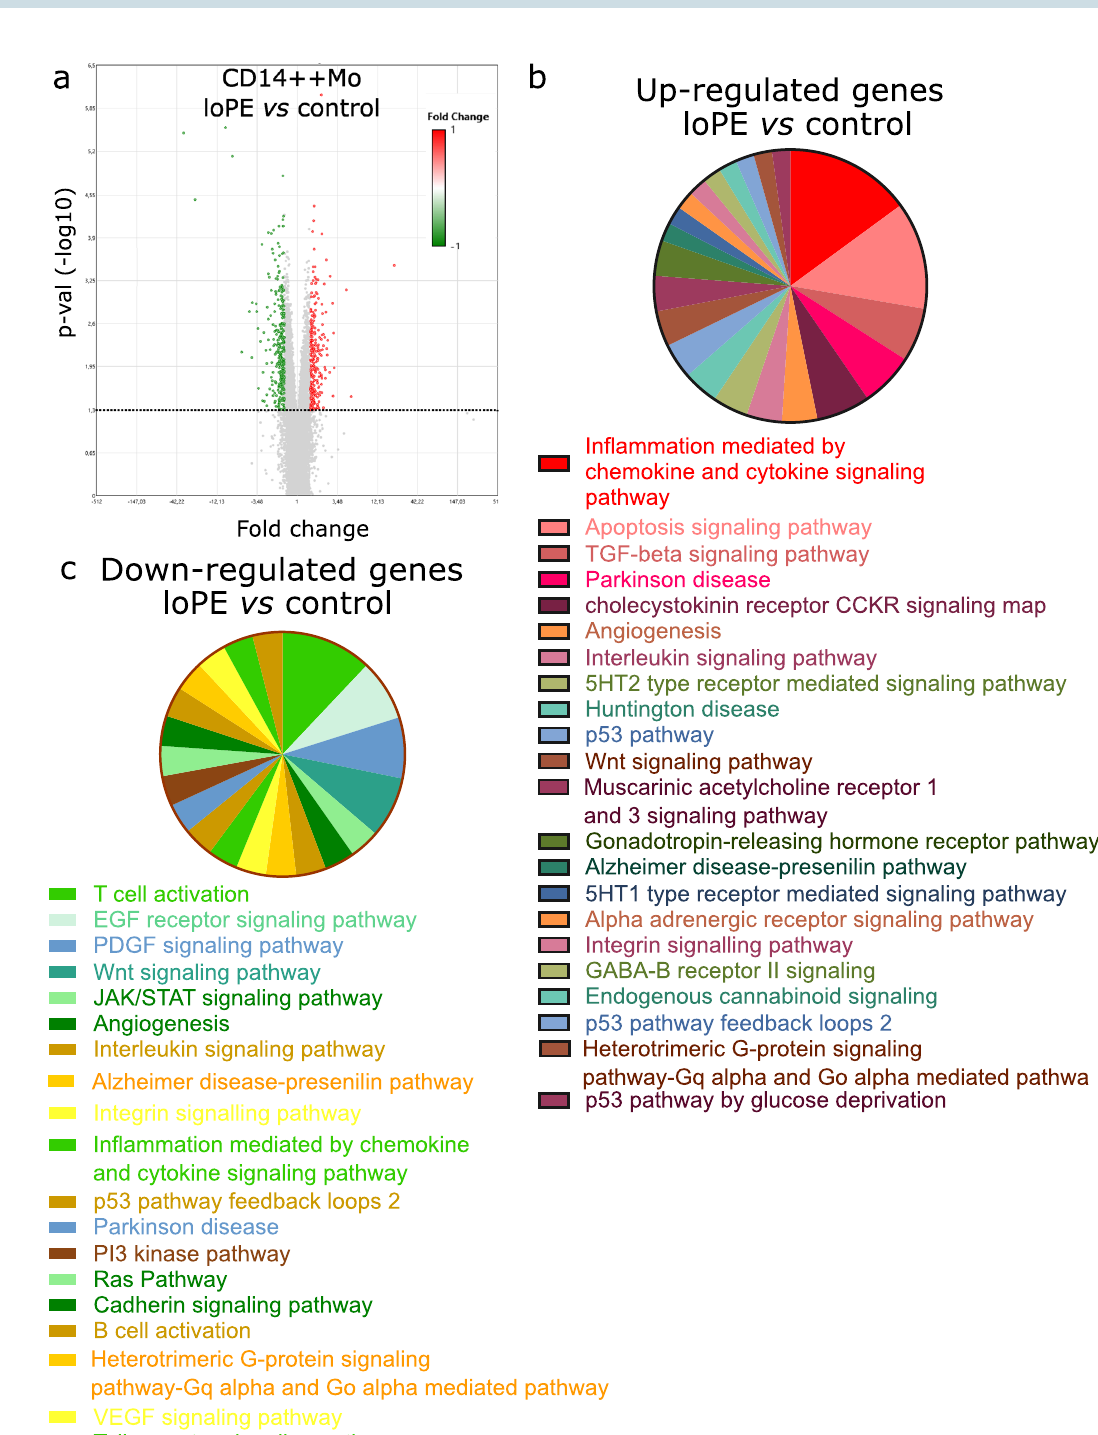
Figure 3. Transcriptomic data (relative gene expression levels) for CD14++ blood monocytes of late-onset PE (loPE) and control groups. Volcano plot ( a ) provides a comparative overview of gene expression in CD14++ monocytes of loPE (n = 6) vs control group (n = 7). Each point in the plot corresponds to a gene. The red- and green-colored genes positioned above the horizontal dotted line are significantly (p < 0.05) up- or down- regulated in loPE CD14++ cells, respectively. The data were analyzed with TAC Software 4.0.2 using Affymetrix default analysis settings and RMA algorithm. Enrichment analysis for upregulated genes ( b ) and downregulated genes ( c ) grouped in the PANTHER ontology by molecular pathway and listed in order starting from the most